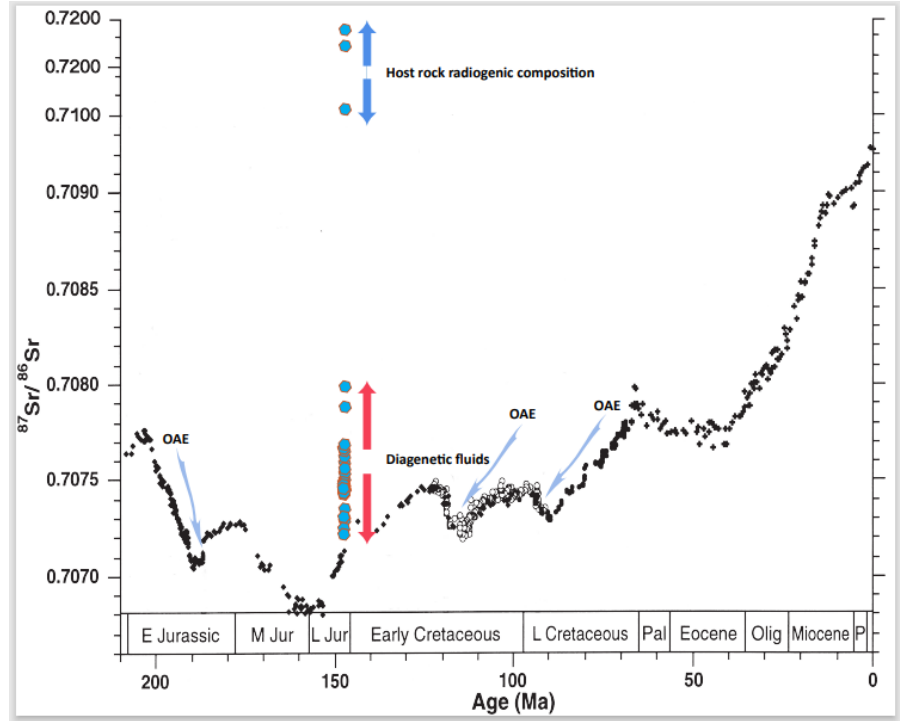
Figure 9. The seawater Sr-isotope curve shows minima in the Late Triassic, Pliensbachian-Toarcian, Callovian-Oxfordian, Aptian-Albian, and Cenomanian-Santonian. The recent study data “blue plots” from our study are shown for comparison. The recent data “this study” populated around two positive excursions: the first host carbonate positive excursion, and the second diagenetic carbonate positive excursion. The host carbonate value is highly radiogenic, higher than the whole seawater Sr isotope curve, while the value of carbonate diagenesis samples is still high and less radiogenic than host carbonate samples (modified after Jones and Jenkyns [9]). OAE = Oceanic Anoxic Event.